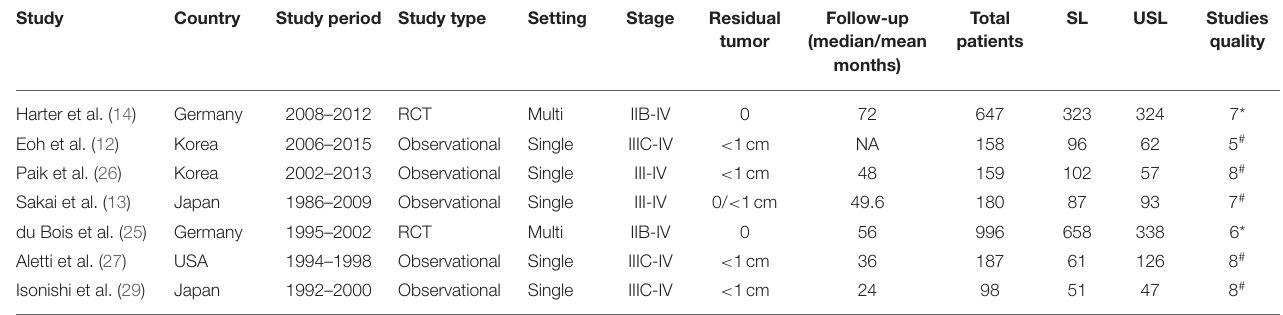
TABLE 1 | Baseline characteristics of the included